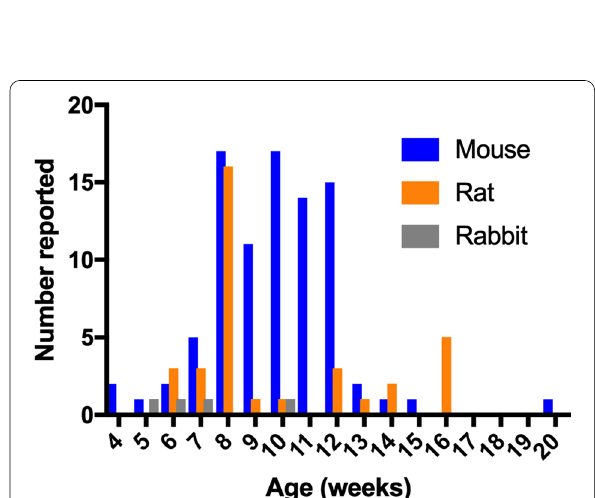
Fig. 4 Age distribution of animals used in imaging inflammatory musculoskeletal studies. Seven studies did not report the ages of animals used